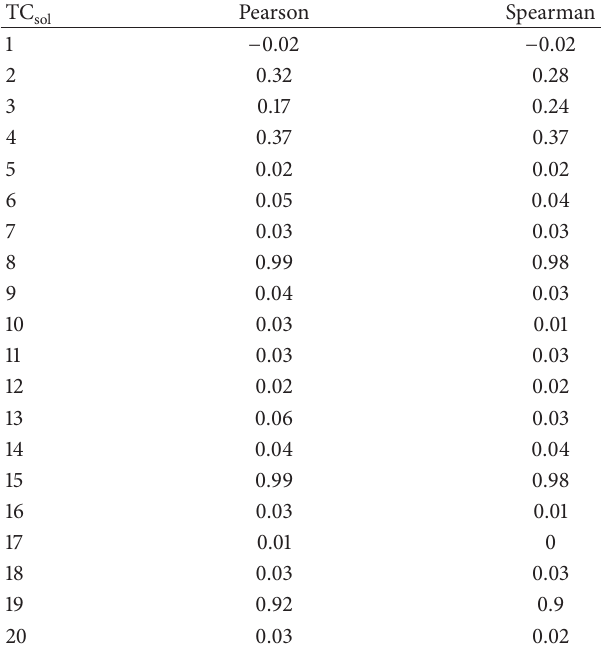
Table 3: TriGen algorithm control parameters for Yeast Cell Cycle Dataset.